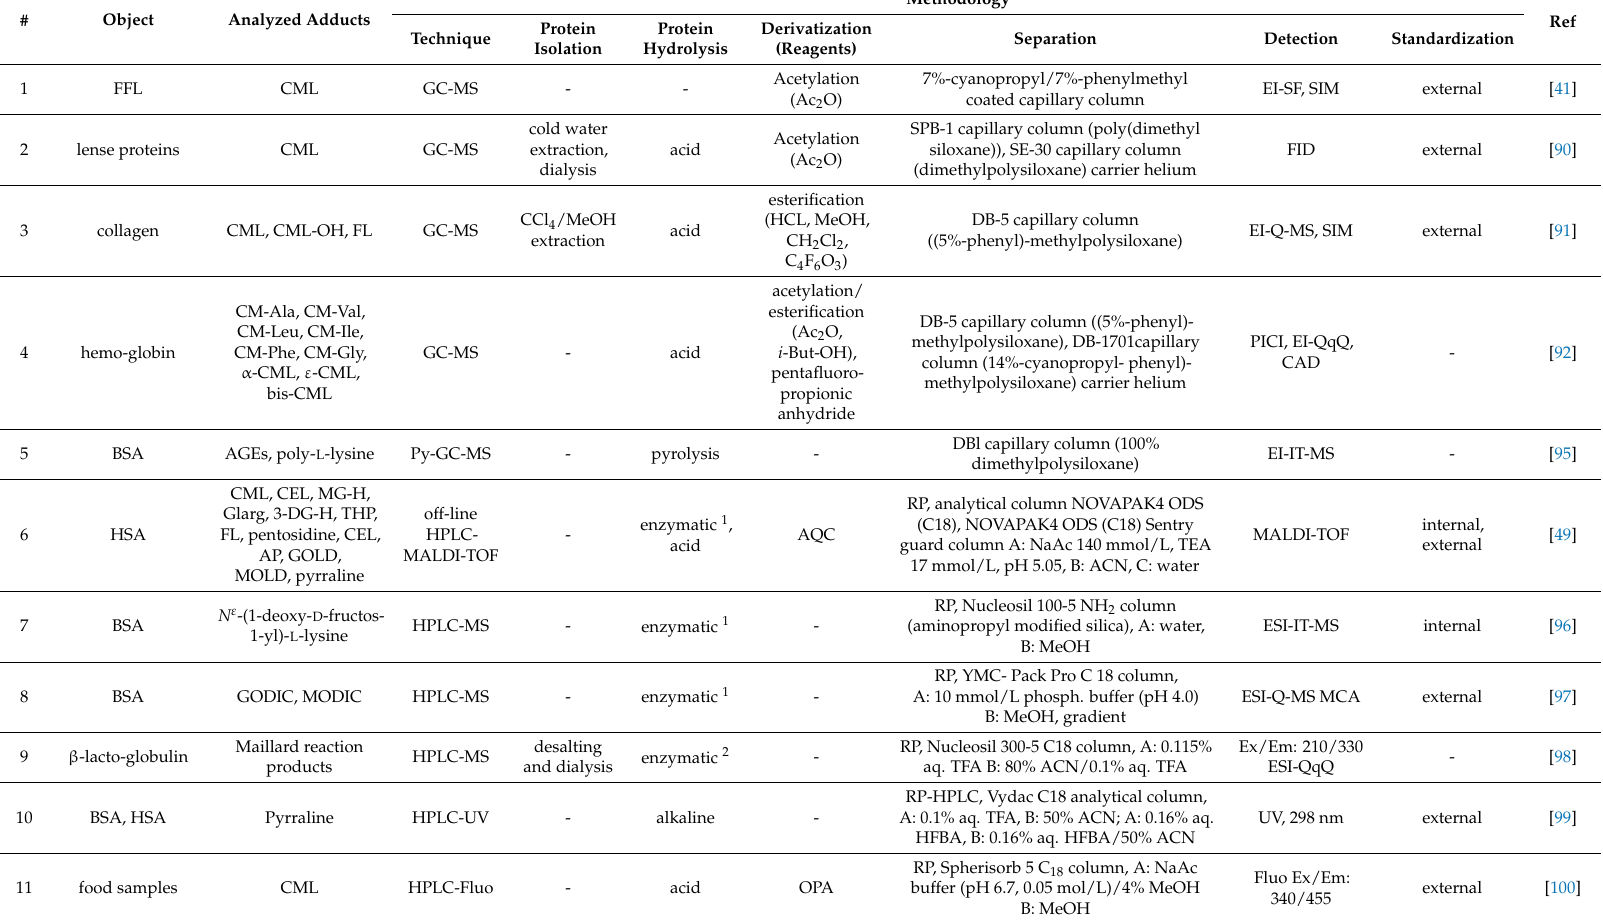
Table 1. Overview of analytical techniques employed in analysis of free and protein-bound glycation